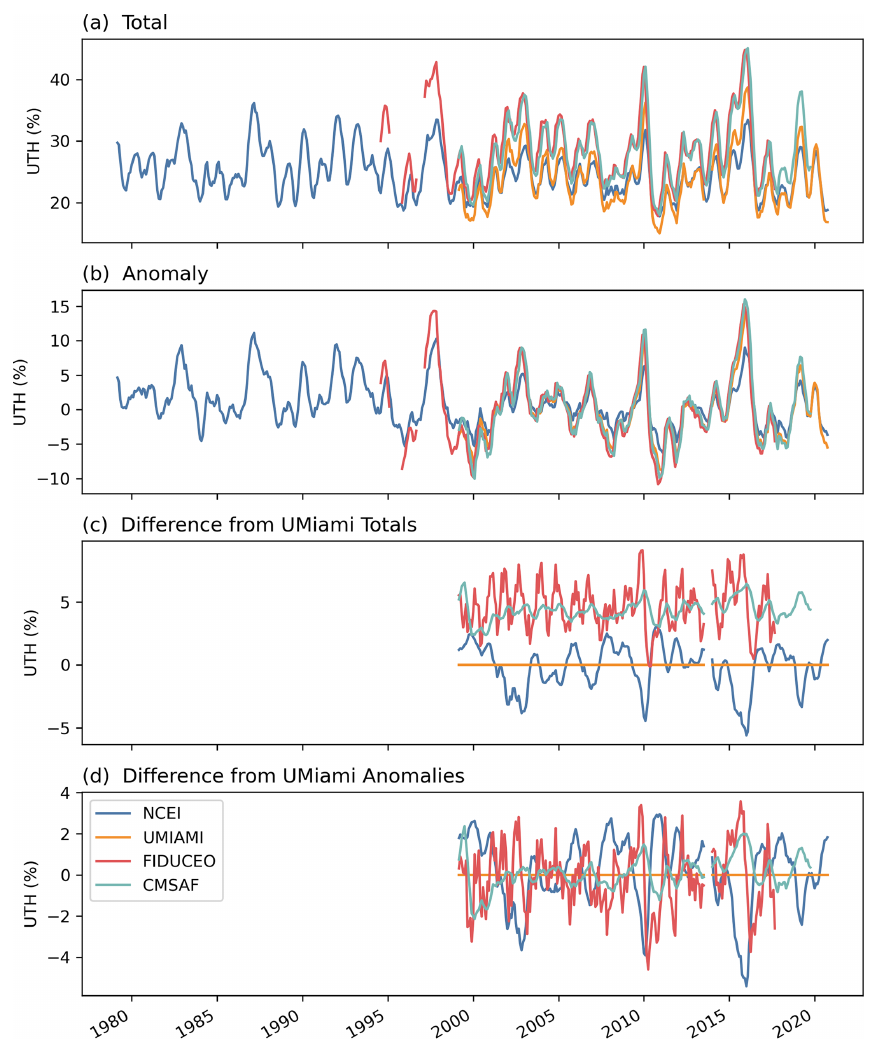
Figure 2. Time series of UTH (%) averaged over the Niño 4 region for (a) the averaged values of UTH, (b) the corresponding anomalies relative to the 2000–2015 climatology, (c) the differences of UTH values relative to the values of UMIAMI, and (d) the differences of anomaly values relative to those of UMIAMI. A 5-month moving average is applied to the UTH time series to reduce short-term